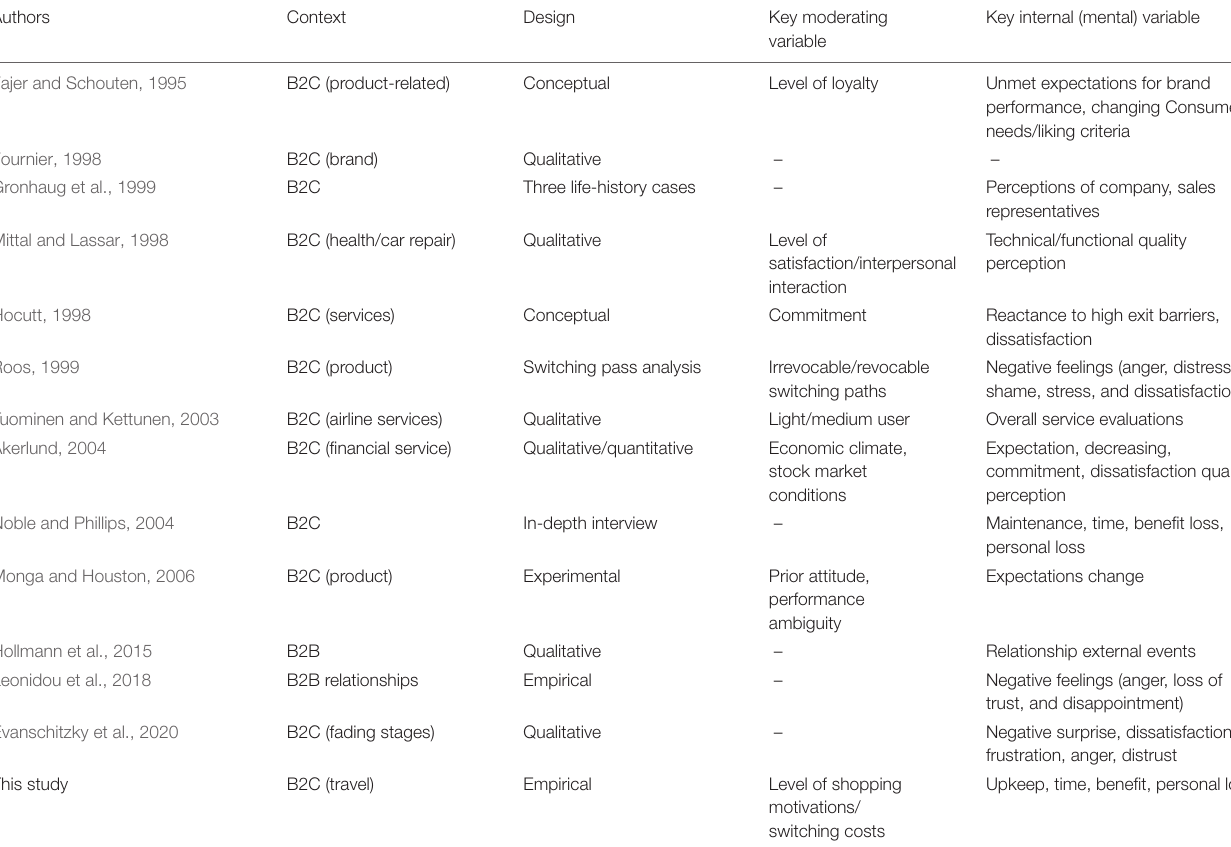
TABLE 1 | Overview of marketing literature highlighting the relationship fading and